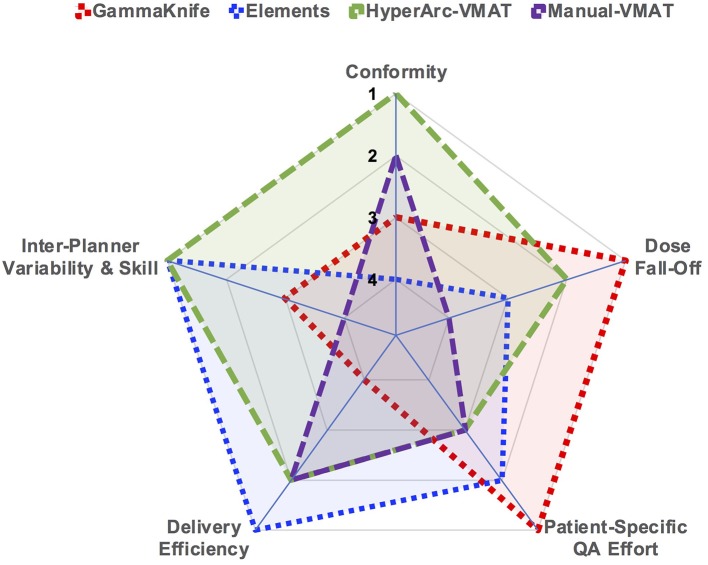
Spider plot graphically comparing the studied SRS techniques across the different categories of dosimetry and efficiency. SRS treatment modalities were ranked relative to each other per specified category on a scale of 1 through 4.